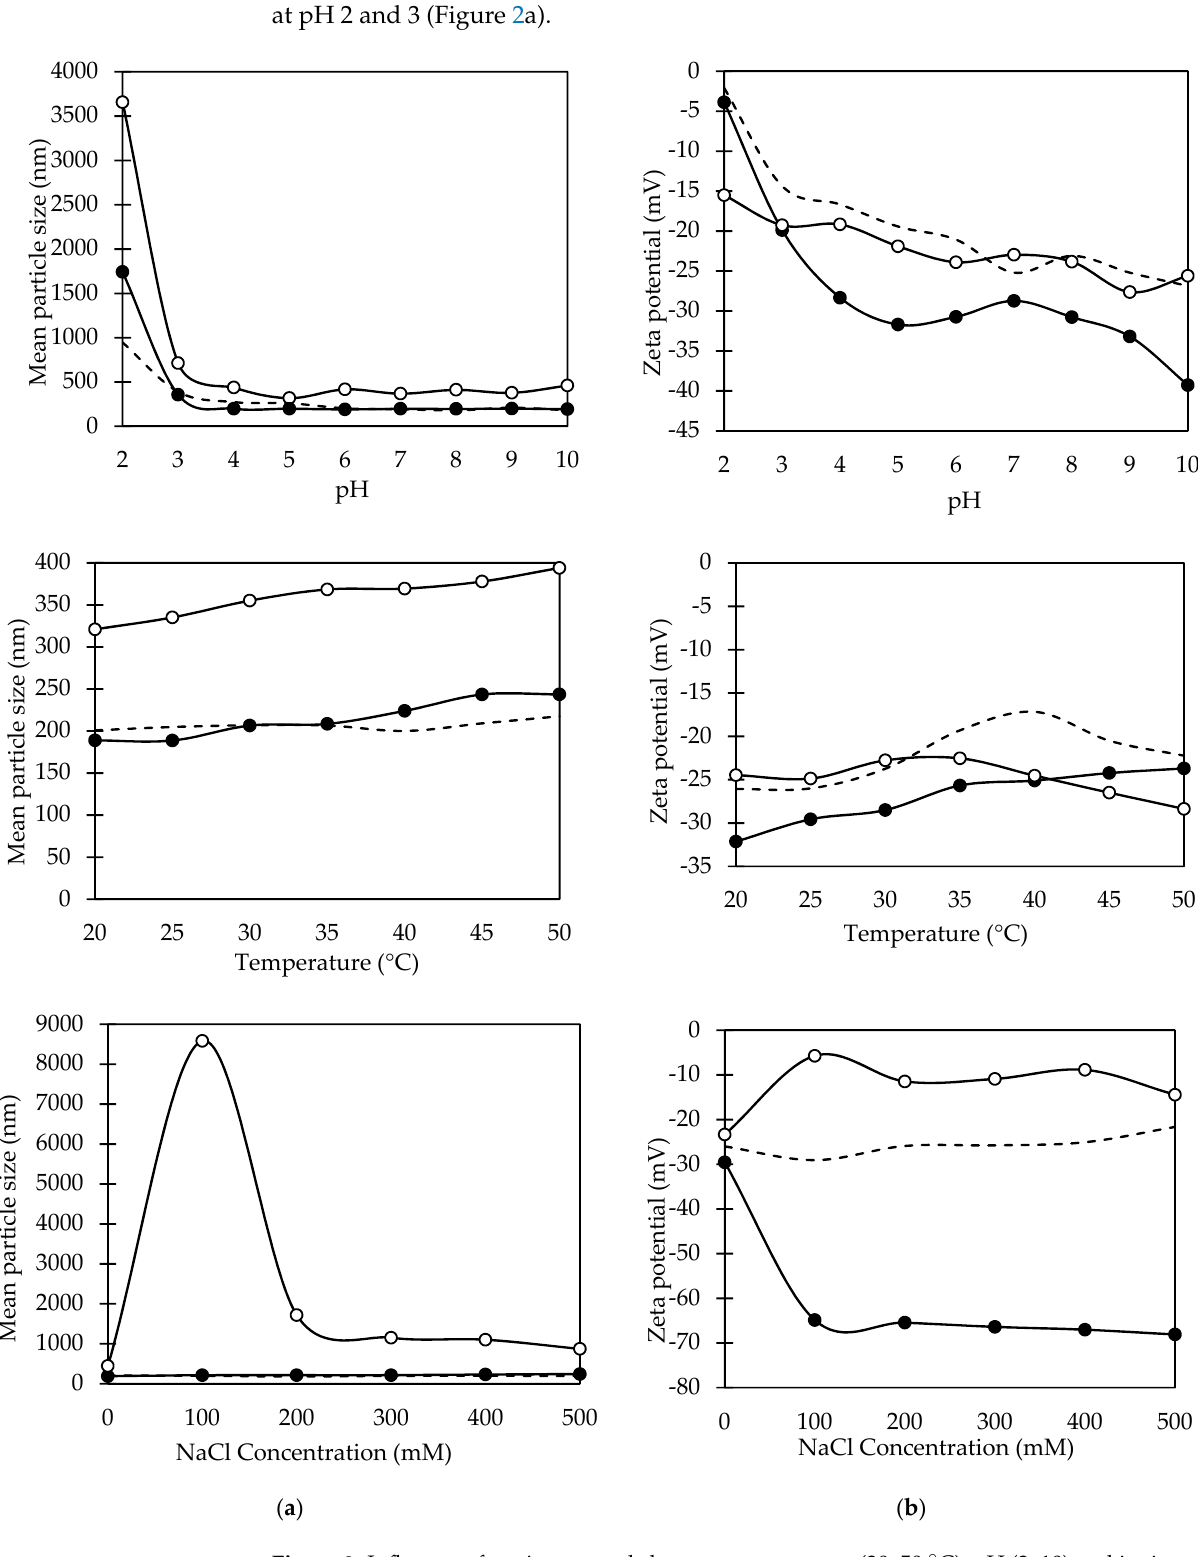
Figure 2. Influence of environmental changes: temperature (20–50 ◦ C), pH (2–10) and ionic strength (0–500 mM) on emulsion stability expressed as changes in ( a ) mean particle size and ( b ) zeta potential for emulsions produced with: ( • ) Quillaja saponaria , ( ) Chenopodium quinoa or (–) Tween 20 as (cid:35) emulsifier. Emulsions were prepared using 1% oil phase and 1%